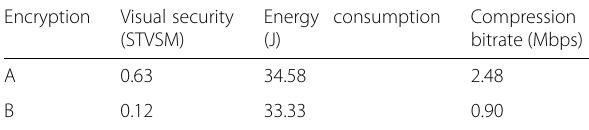
Table 1 Example tradeoff in terms of visual security, energy consumption, and compression bitrate